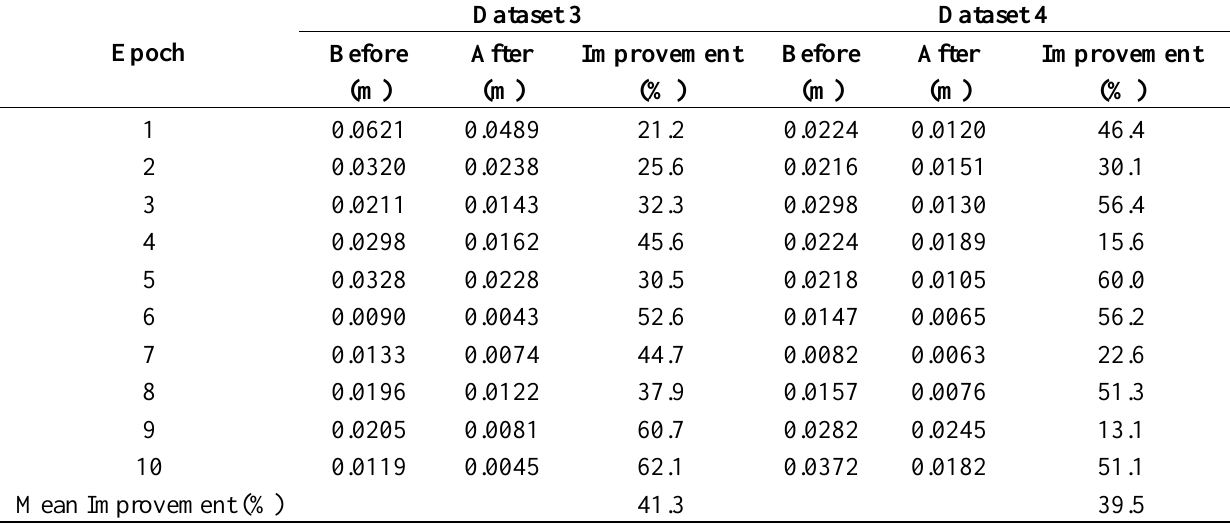
Table 2. RMS of the check plane fitting misclosures for an individual laser in kinematic